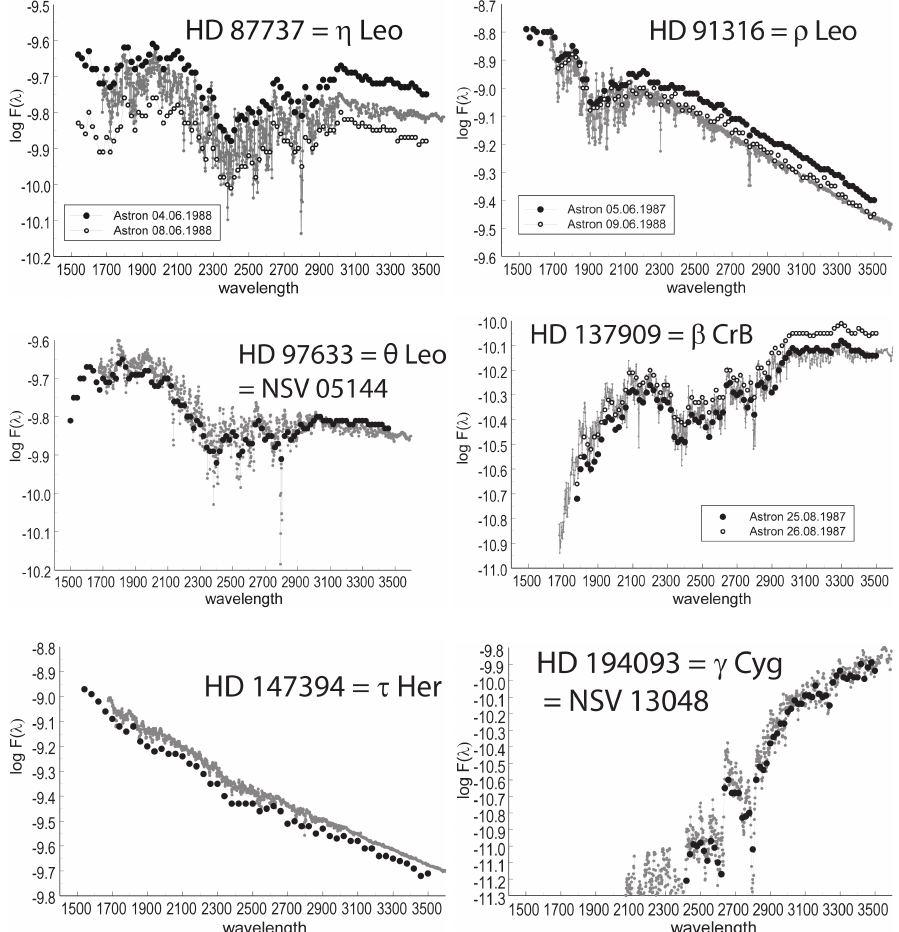
Fig. 2. Comparison between the NGSL and Astron data. Grey color: NGSL; black solid or open circles: Astron. (Continued from Fig.